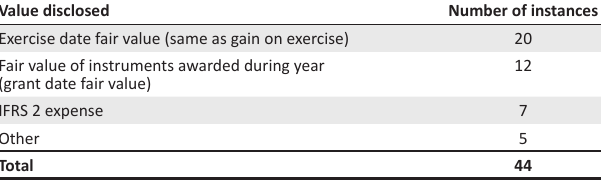
TABLE 3: Measurement of value disclosed in table with short-term remuneration. Value disclosed Number of